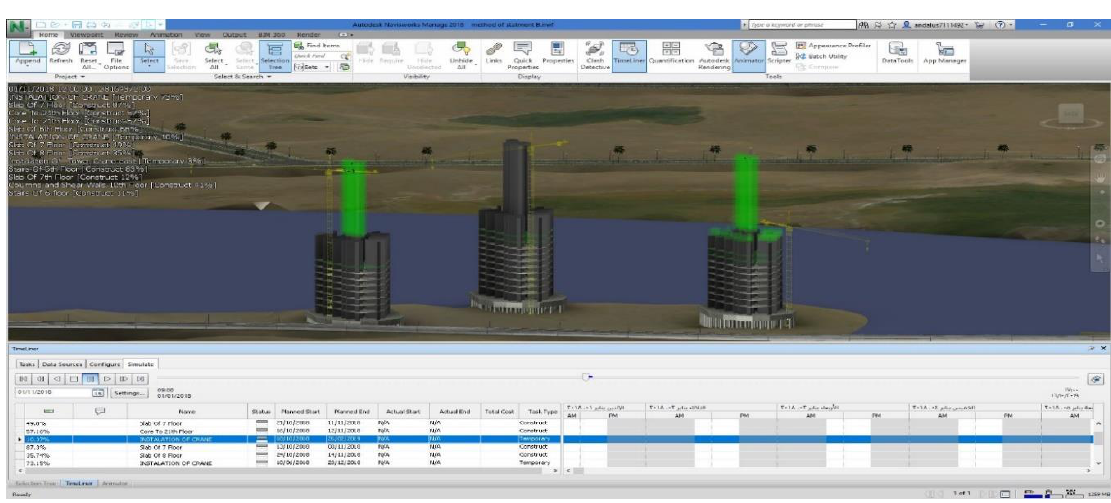
Figure 6: Navisworks (M.O.S 1 – The towers /ALAMEIN).